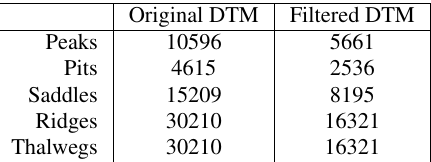
Table 1: Number of vertices and edges in the drainage network. Saddles are counted with their multiplicity.